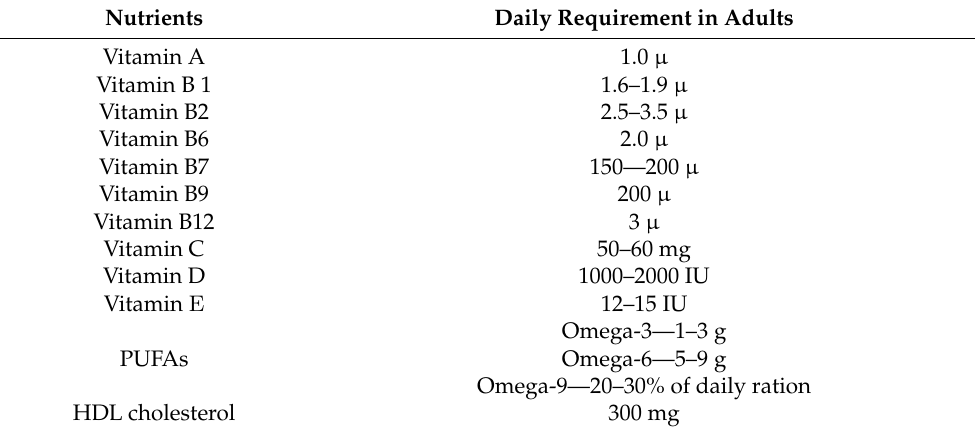
Figure 14. The role of nutrients in reducing the risk of developing and the progression of amyotrophic lateral sclerosis (ALS). Table 3. Recommended average daily intake of nutrients that can be used as promising protectors against